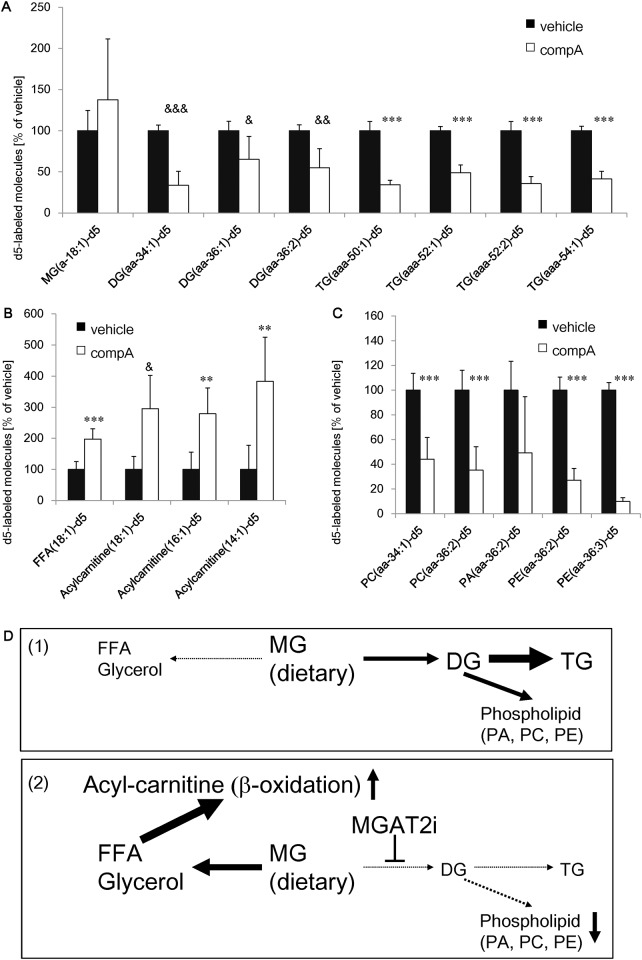
Lipid metabolic flux analysis of compA in intestinal mucosa.Fasted C57BL/6J mice were orally administered 30 mg/kg compA. Two hours after dosing, they were orally administered a liquid meal containing the 2H-labeled oleoylglycerol. Glycerol-labeled monoacylglycerol (MG) was used in panels 2A and 2C, and fatty acid-labeled MG was used in panel 2B as a tracer. (A) Intestinal 2H-labeled MG, diacylglycerol (DG), and triglyceride (TG) levels. (B) Intestinal 2H-labeled fatty acid and acylcarnitine levels. (C) Intestinal 2H-labeled phospholipids levels. n = 5. **: P < 0.01, ***: P < 0.001 vs. vehicle group by Student's t-test. &: P < 0.05, &&: P < 0.01, &&&: P < 0.001 vs. vehicle group by Aspin–Welch test. (D) Scheme of MGAT2 inhibitor-mediated intestinal fat metabolism. (1) Most of the dietary MG and free fatty acids (FFAs) is used as a source of TG resynthesis in enterocytes. Some of the synthesized DGs are pooled as phospholipids. (2) MGAT2 inhibitor suppresses DG/TG resynthesis. Transiently stored MG is hydrolyzed into glycerol and FFAs. The activated FFA (acylcarnitine) is transported into mitochondria as a substrate of β-oxidation.